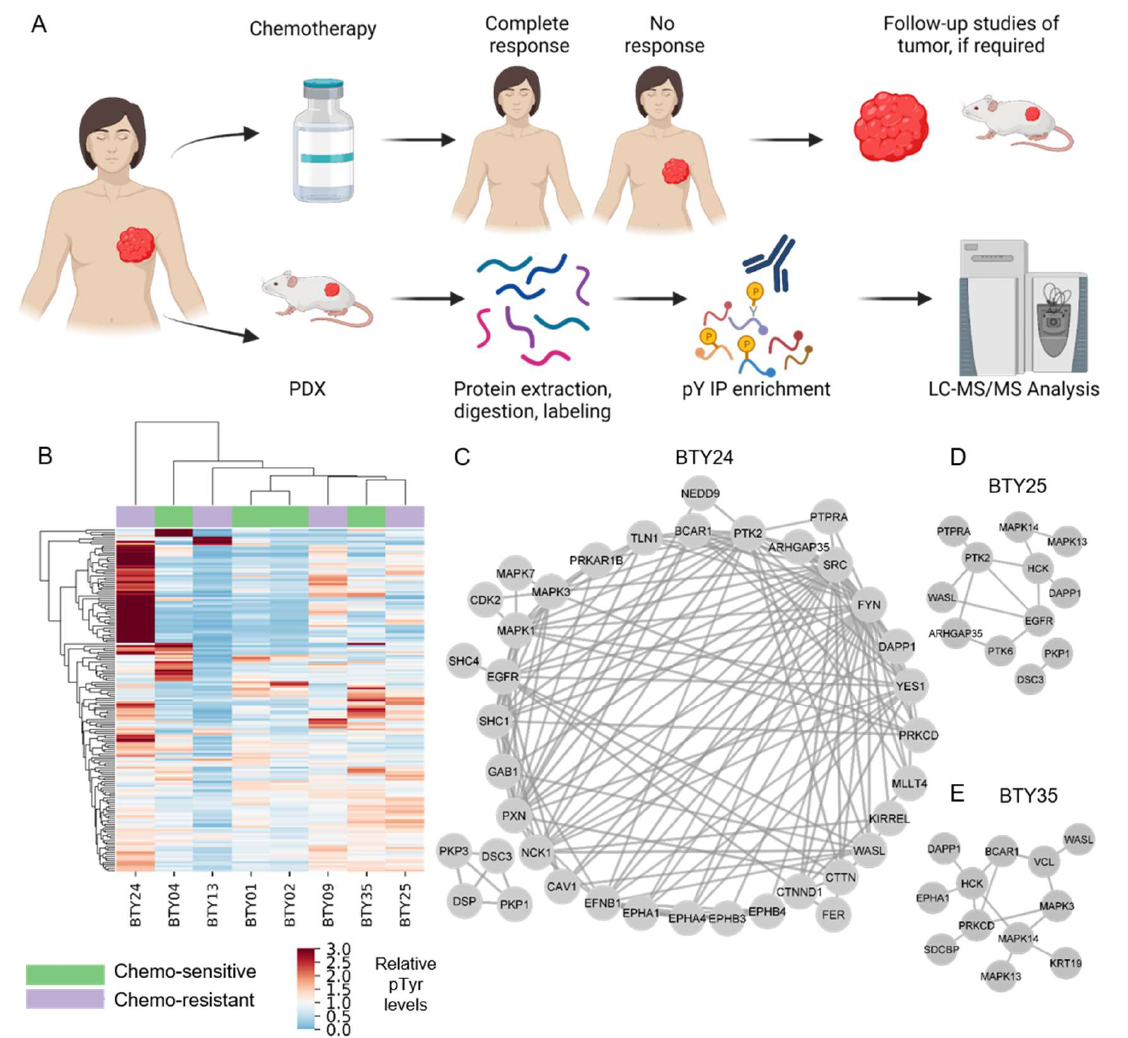
Figure 1. Phosphotyrosine analysis of PDXs from TNBC patients. ( A ) Schematic of PDXs established from baseline tumors that were either classified as chemotherapy sensitive (CS) or resistant (CR). ( B ) Hierarchical clustering heatmap of pTyr peptides quantified in PDXs established from four CS and four CR patients. Clustering is based on the average Euclidean distance metric. Phosphorylation levels were mean normalized across the PDXs. ( n = 2–3/PDX line, total 23 PDXs) ( C – E ) Interaction network of pTyr-proteins that were highly phosphorylated in PDX05 line ( C ), BTY25 ( D ), and BTY35 ( E ). pTyr sites belonging to these proteins had a greater than 1.5 fold change in their respective PDX lines compared to other PDX lines.